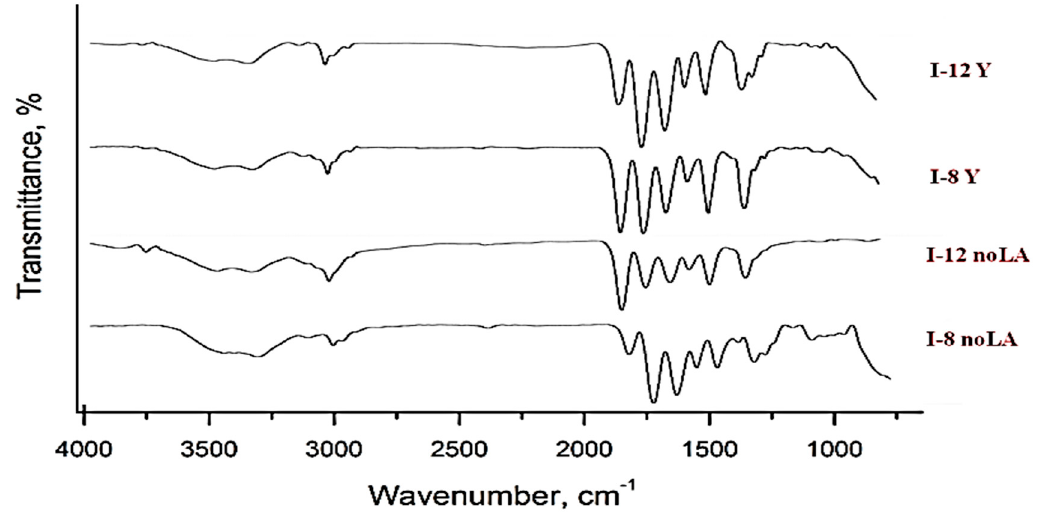
Figure 4. FTIR spectra of P(nipam-co-IAM) with and without stereo-control.